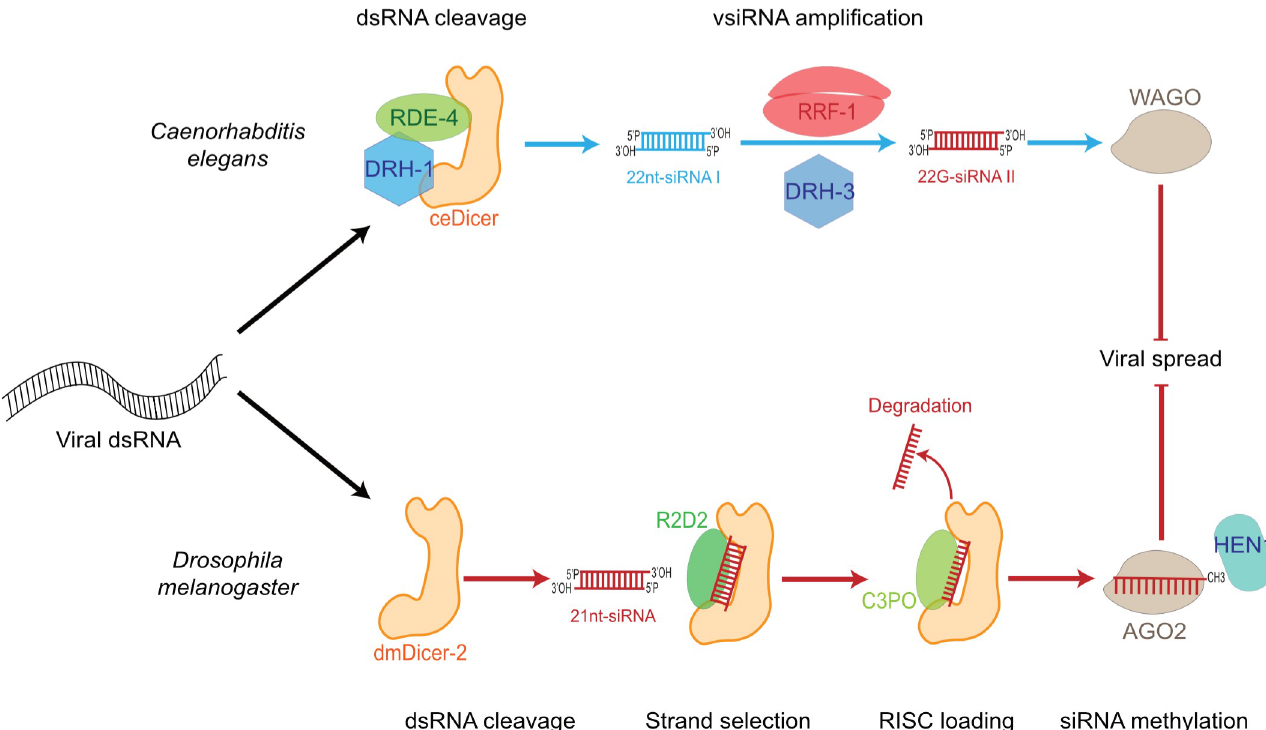
Fig 2. Antiviral RNAi pathways in Caenorhabditis elegans and Drosophila melanogaster . Upon viral infection, dsRNA triggers RNAi after its recognition by Dicer. In C . elegans , Dicer helped by the dsRBP RDE-4 and another DExD/H-box helicase, DRH-1, recognizes the dsRNA and processes it into primary 22 nt siRNA duplexes. These duplexes serve as a template for the generation of secondary 22G-siRNA by the polymerase RRF-1 and a third helicase called DRH-3. They are finally loaded into an Argonaute protein, WAGO. In D . melanogaster , Dicer-2 recognizes and cleaves the viral dsRNA into 21nt-siRNA duplexes. Strand selection occurs with the help of the dsRBP R2D2, and the passenger strand is sliced by Ago2 before being degraded by the nuclease C3PO. The guide strand is then 2 0 -O-methylated at the 3 0 end by HEN1 to be stabilized. For both worms and flies, the loaded Argonaute protein can then cleave viral complementary sequences, resulting in the antiviral state. dsRNA, double-stranded RNA; RNAi, RNA interference; siRNA, small interfering RNA; vsiRNA, virus-derived small interfering RNA.